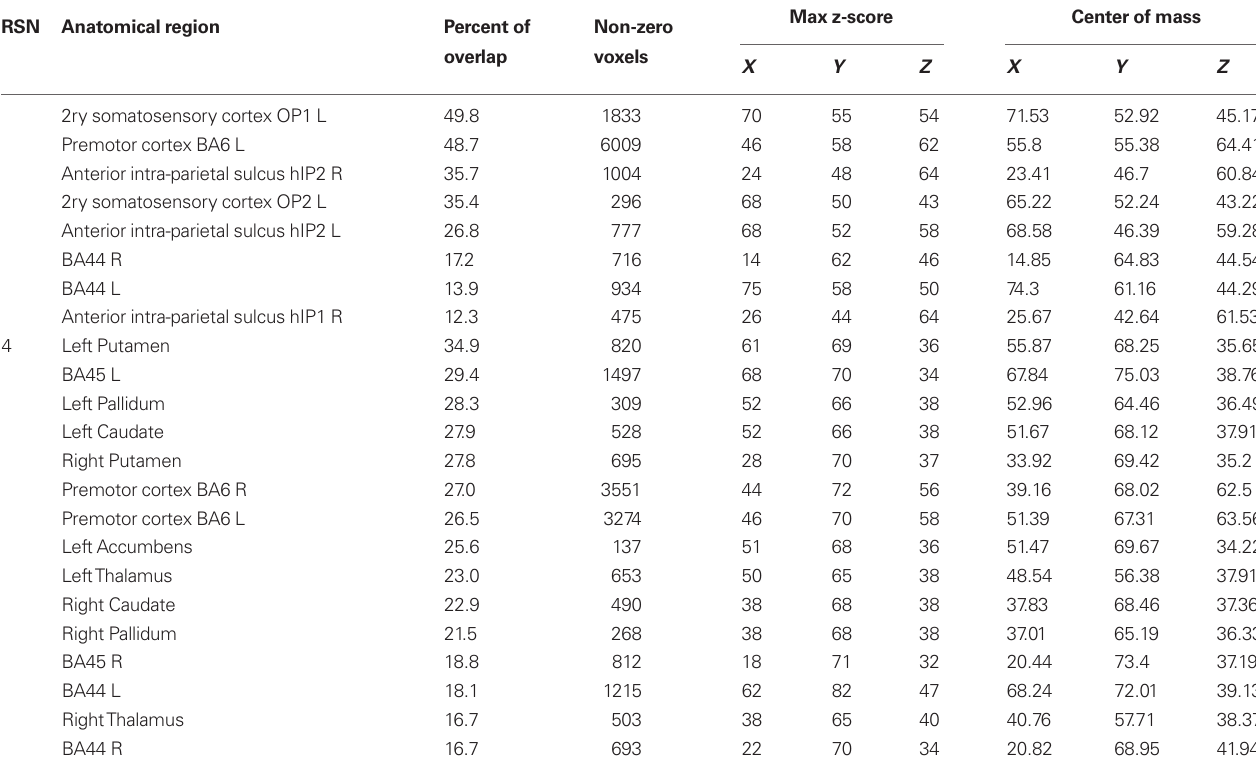
Large-scale RSNs are demonstrated by: anatomical regions involved, number of voxels, and MNI coordinates (in mm) of maximum z-scores, and center of mass.